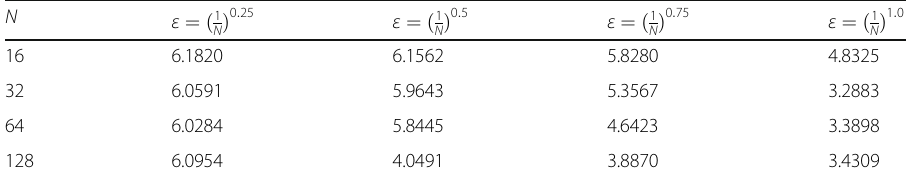
Table 5 Rate of convergence for Example 2